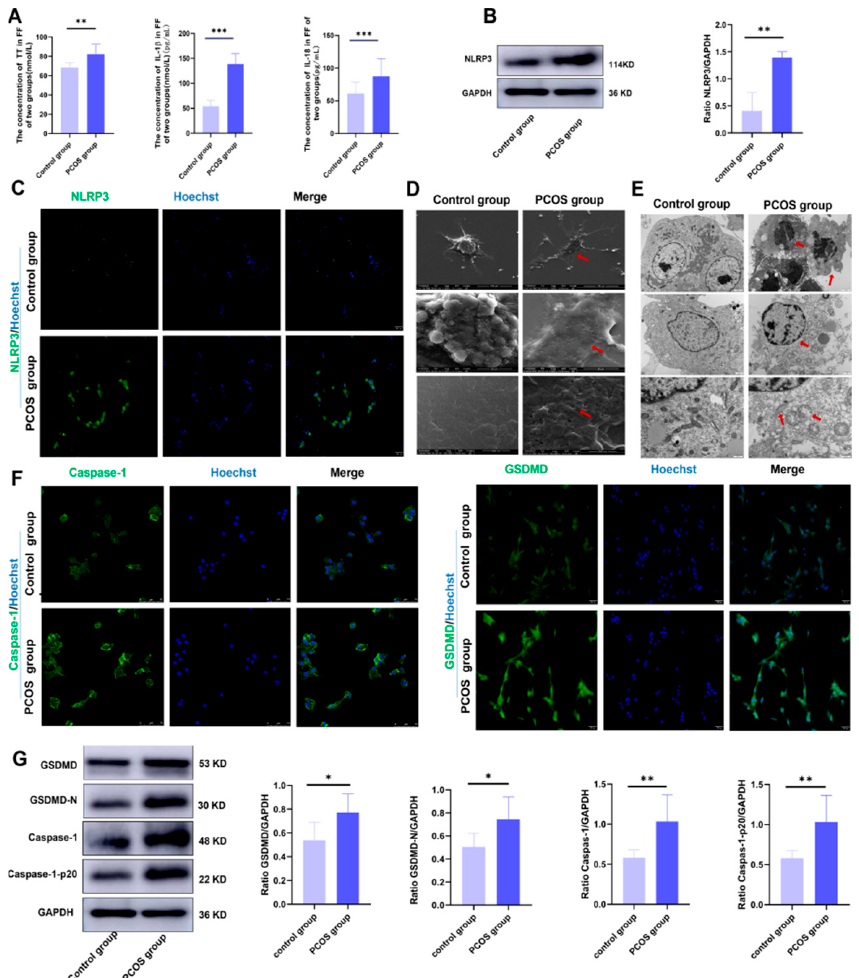
Figure 1. Hyperandrogenism causes pyroptosis of ovarian GCs by activating NLRP3 inflammasome in PCOS patients. ( A ) The expression of TT, IL-18, and IL-1 β in follicular fluid were analyzed using enzyme-linked immunosorbent assay kits in the PCOS group and the control group; ( B ) the expression of NLRP3 inflammasome of ovarian GCs was analyzed with Western blot in the two groups; ( C ) the expression of NLRP3 inflammasome of ovarian GCs was analyzed with immunofluorescence staining of the two groups. The scale is 50 um. ( D ) The pyroptosis characteristics of ovarian GCs were observed with scanning electron microscopy; ( E ) the pyroptosis characteristics of ovarian GCs in the two groups were observed with transmission electron microscopy; ( F ) the expression levels of caspase-1 of ovarian GCs were analyzed with immunofluorescence staining. The scale is 75 um. The expression levels of GSDMD of ovarian GCs were analyzed with immunofluorescence staining. The scale is 50 um. ( G ) The expression levels of pyroptosis-related proteins of ovarian GCs were analyzed with Western blot. Data are shown as mean ± SEM. * p < 0.05, ** p < 0.01, *** p <